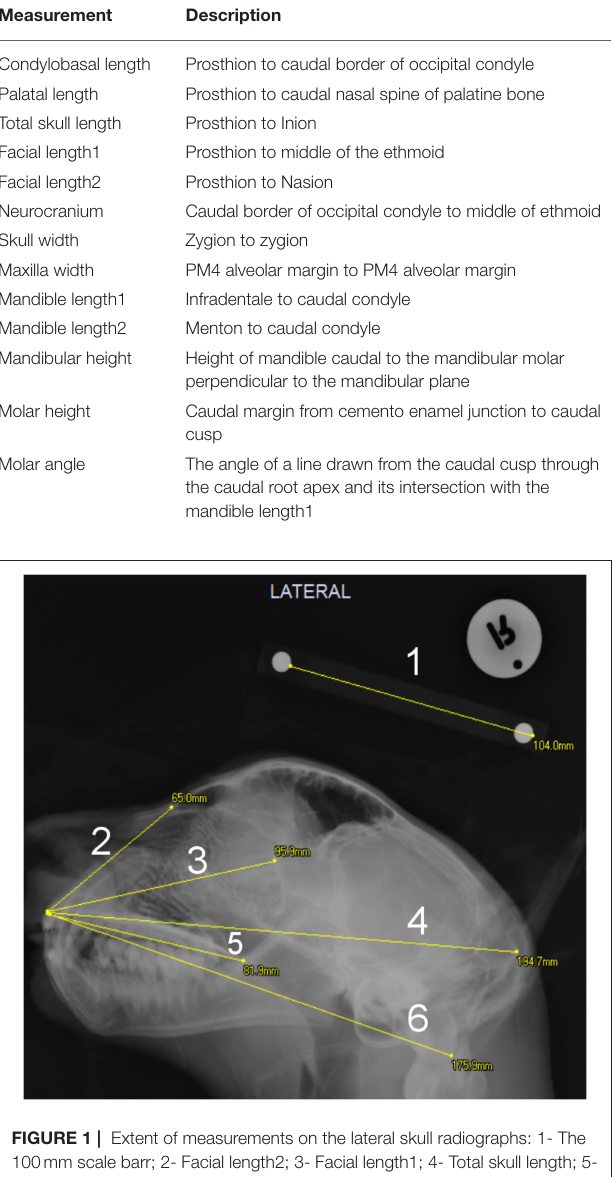
TABLE 2 | Measurements used to describe the cephalometrics of development in the skulls of five growing cheetah cubs. Measurement